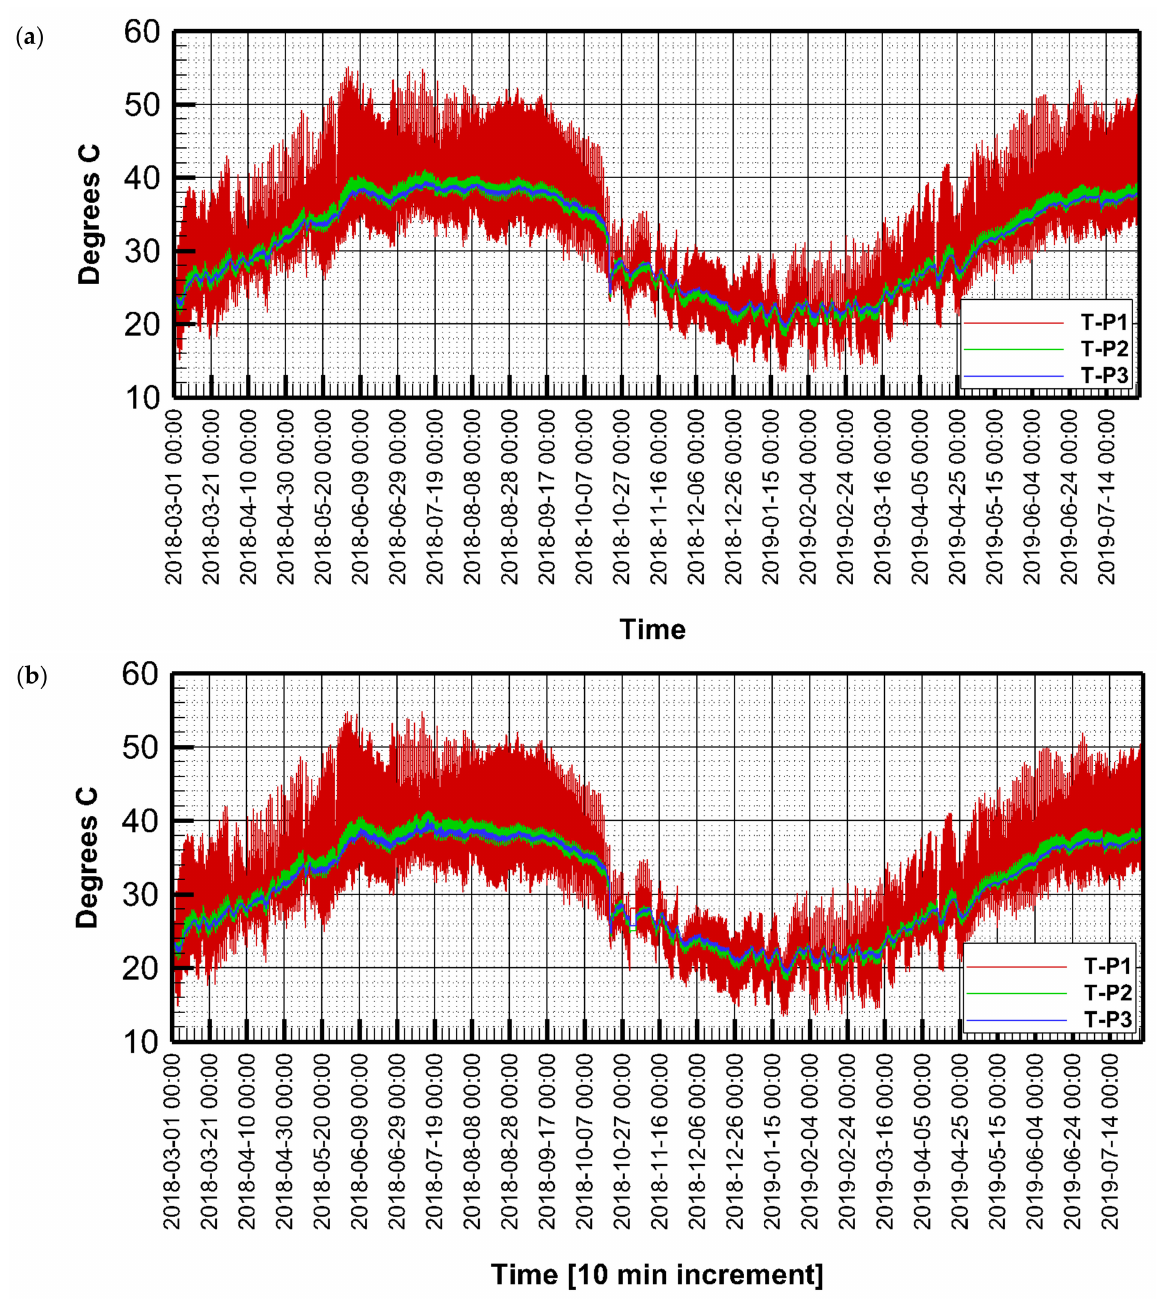
Figure 4. Temperature in ◦ C for lysimeter 1 ( a ) and lysimeter 2 ( b ). The upper probe (T-P1) shows high fluctuation, as it is closer to the ambient air temperature, whereas temperatures at the lower probe were stable. The highest recorded temperature at the upper probe (T-P1) was 55.1 ◦ C, which was recorded around noontime on the 2 June 2018, and 12 July 2018. The lowest recorded temperature at the upper probe was 13.4 ◦ C, which was recorded in the early hours of the morning on the 23 January 2019 and the 7 February 2019. The minimum temperature at the probe T-P2 was 18.3 ◦ C, which was recorded on 22 January 2019, and the maximum was 41.10 ◦ C, which was recorded on the 13 July 2018. The minimum temperature at T-P3 was 19.40 ◦ C, which was recorded on 23 of January, and the maximum temperature was 39.40 ◦ C, which was recorded